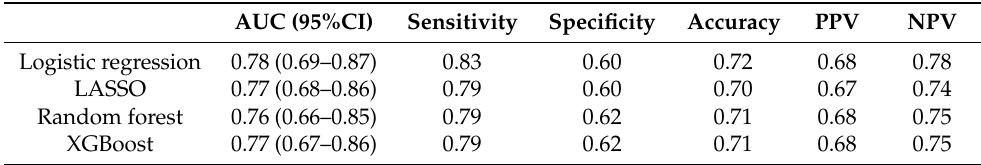
Table 4. The model performances on test set ( N = 106) after feature selection.